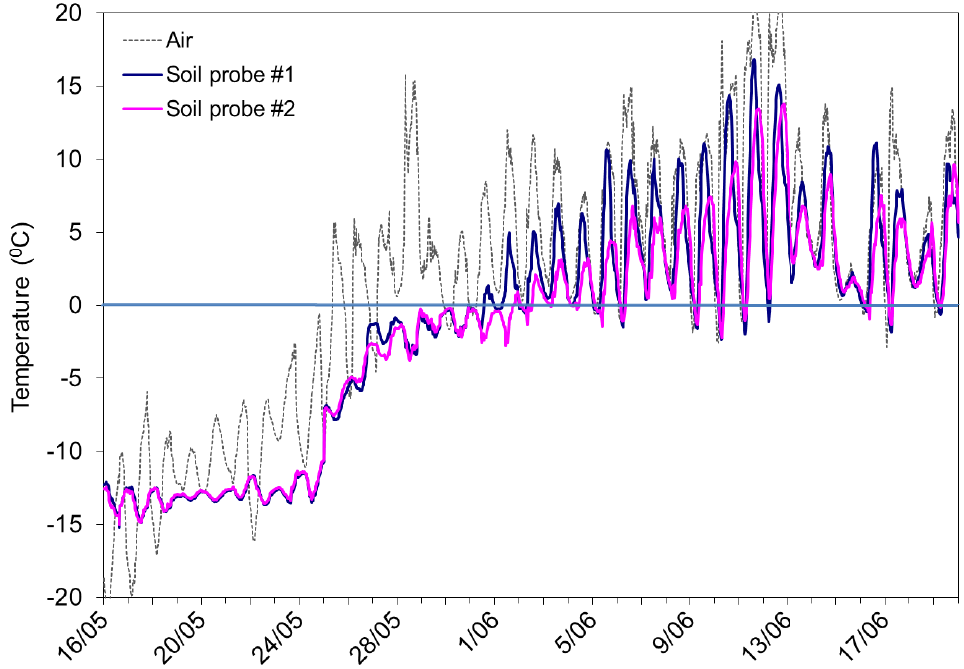
Figure 1. Temperatures in the air (40 cm above the ground surface) and in the soil (2 cm depth) at two locations at least 2 m apart beneath birch hummock tundra vegetation at the Daring Lake site. Temperatures were measured in the spring (2005) with dates as indicated on the X-axis. Data were collected every 30 min using copper-constantan thermocouples and a